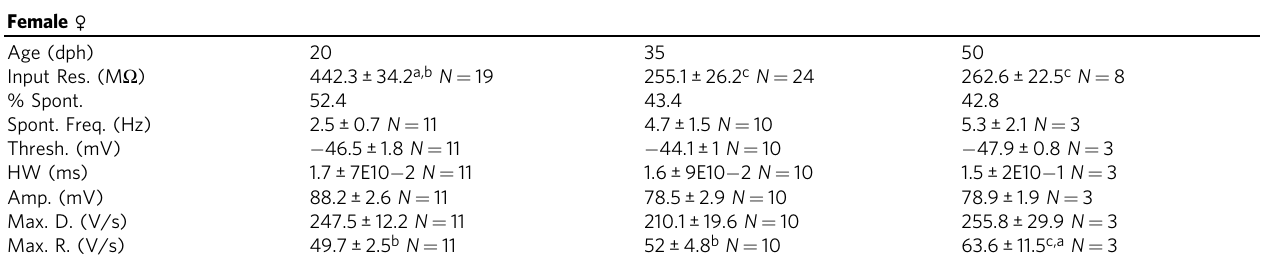
Table 4 Passive and spontaneously active properties of female arcopallial neurons.